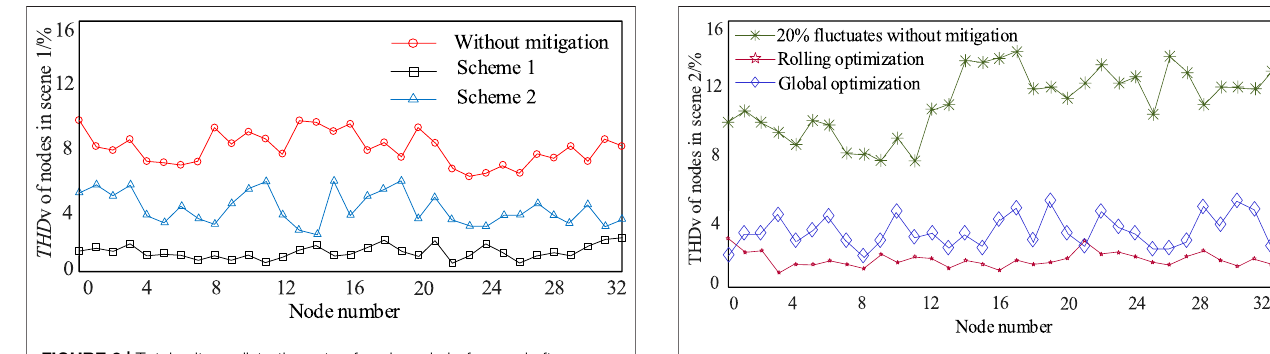
FIGURE 5 | Comparison results of operating point mitigation between rolling optimization and global optimization under scenario